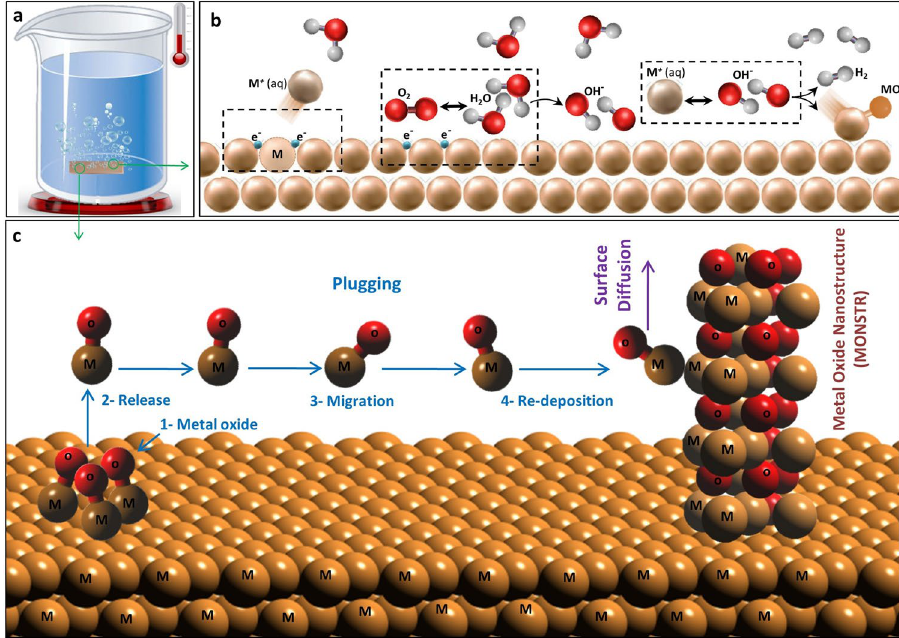
Figure 4. HWT process and steps involved in the formation of MONSTRs. ( a ) HWT process, ( b ) metal oxide formation during HWT at metal/water interface, and ( c ) steps involved in the formation of MONSTR during HWT are illustrated. Main nanostructure formation mechanism includes “plugging” and surface